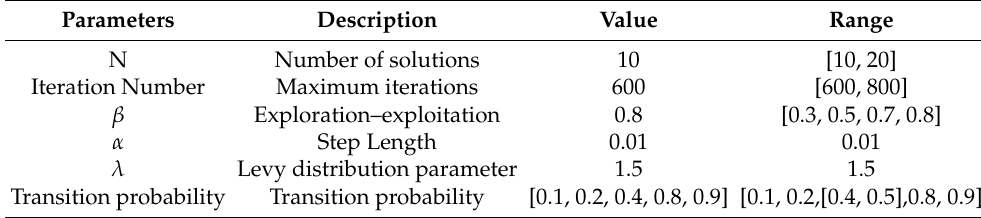
Table 5. Scanned parameters for the cuckoo search